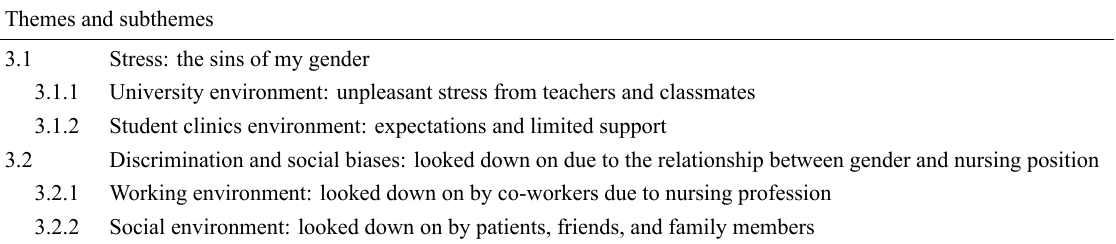
Table 1. Themes and